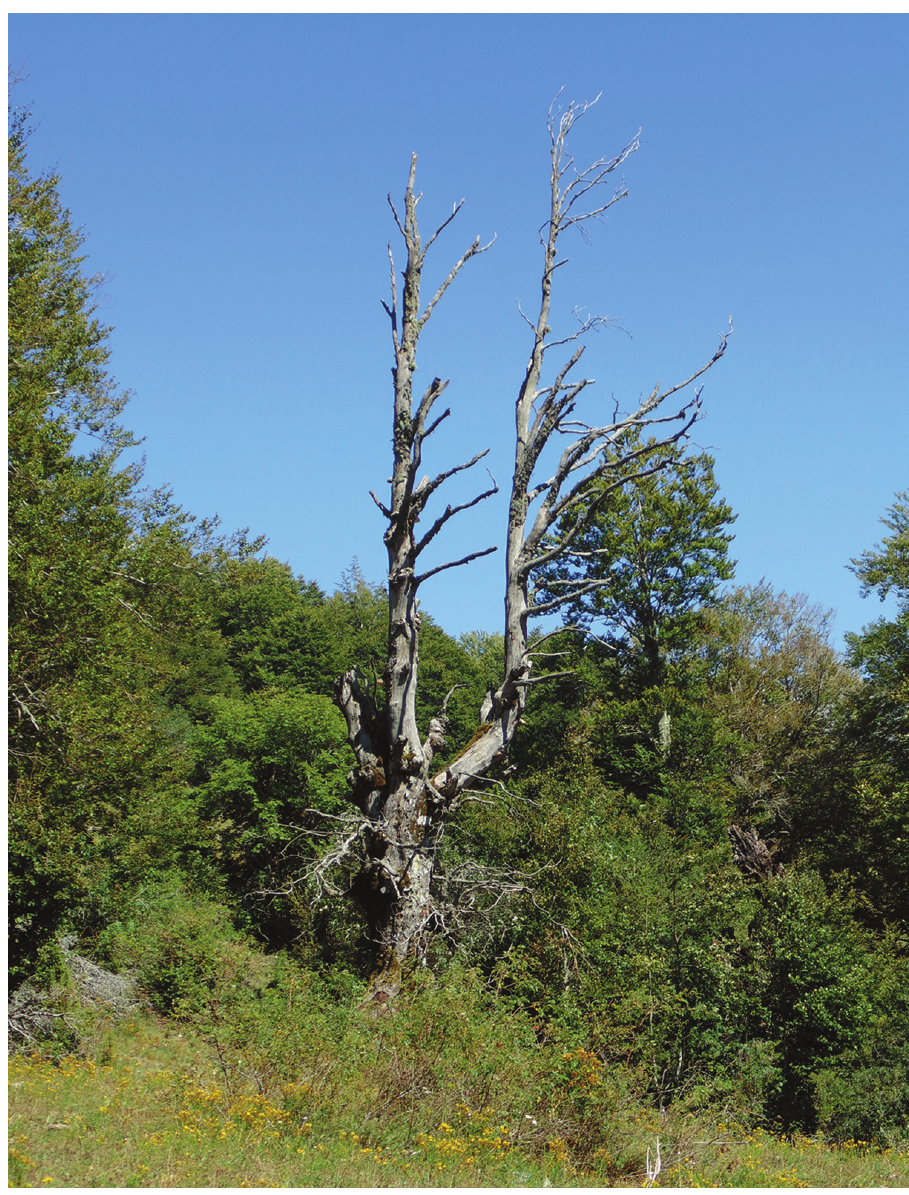
Figure 3. A wild tree used as sampling unit for the monitoring of R. alpina in the Abruzzo, Lazio and Molise National Park during